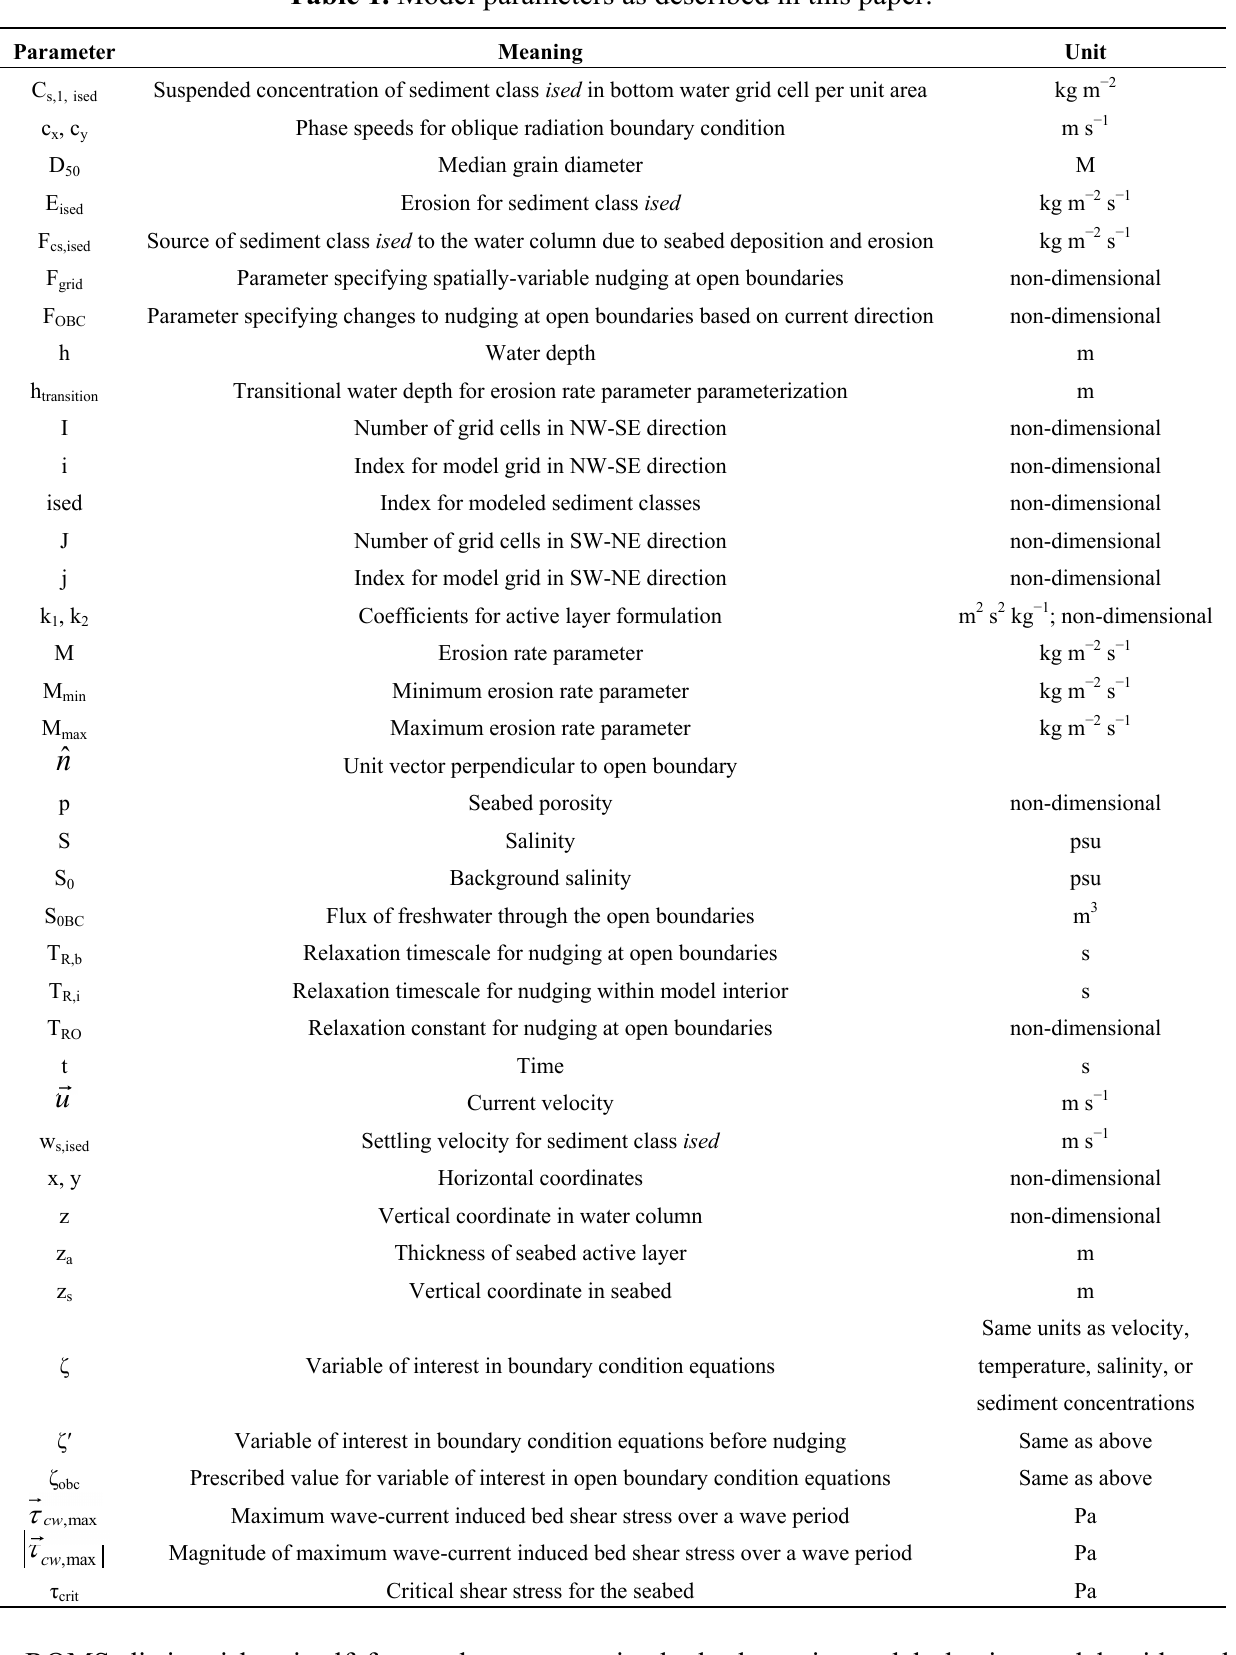
Table 1. Model parameters as described in this